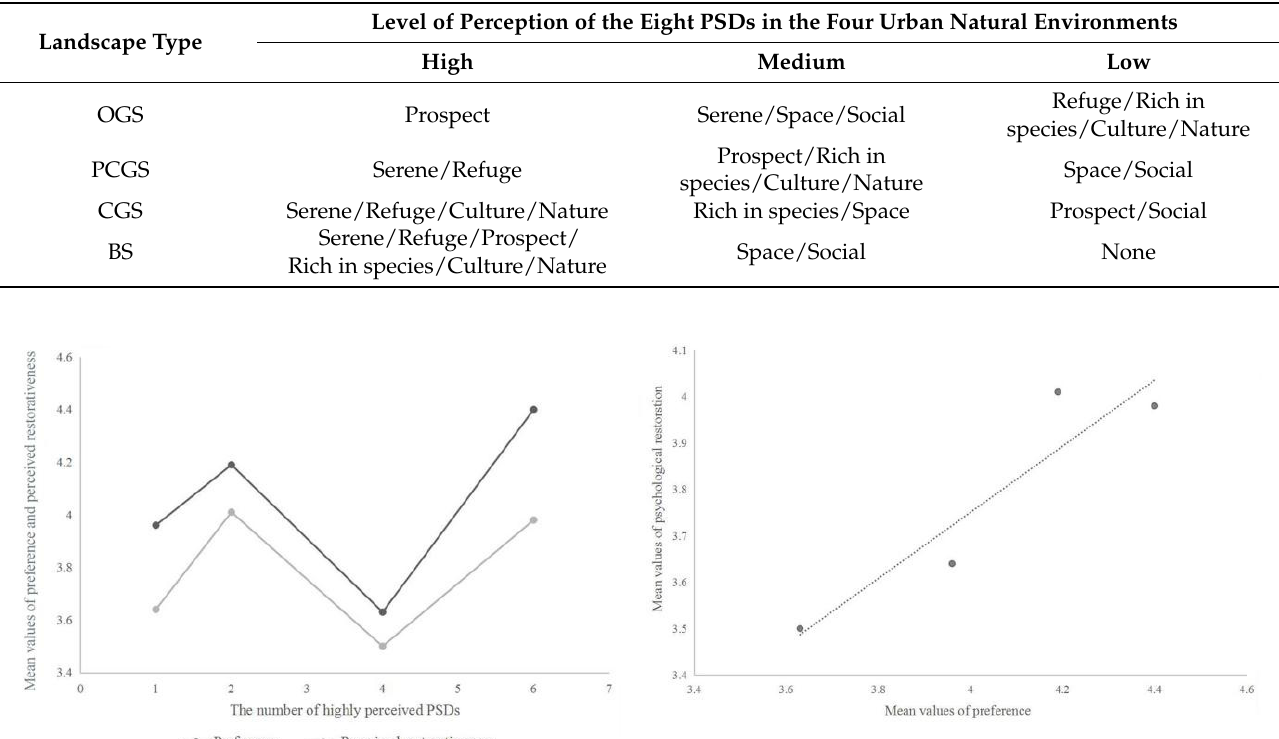
Table 4. The three-scale levels of perception of the eight PSDs.